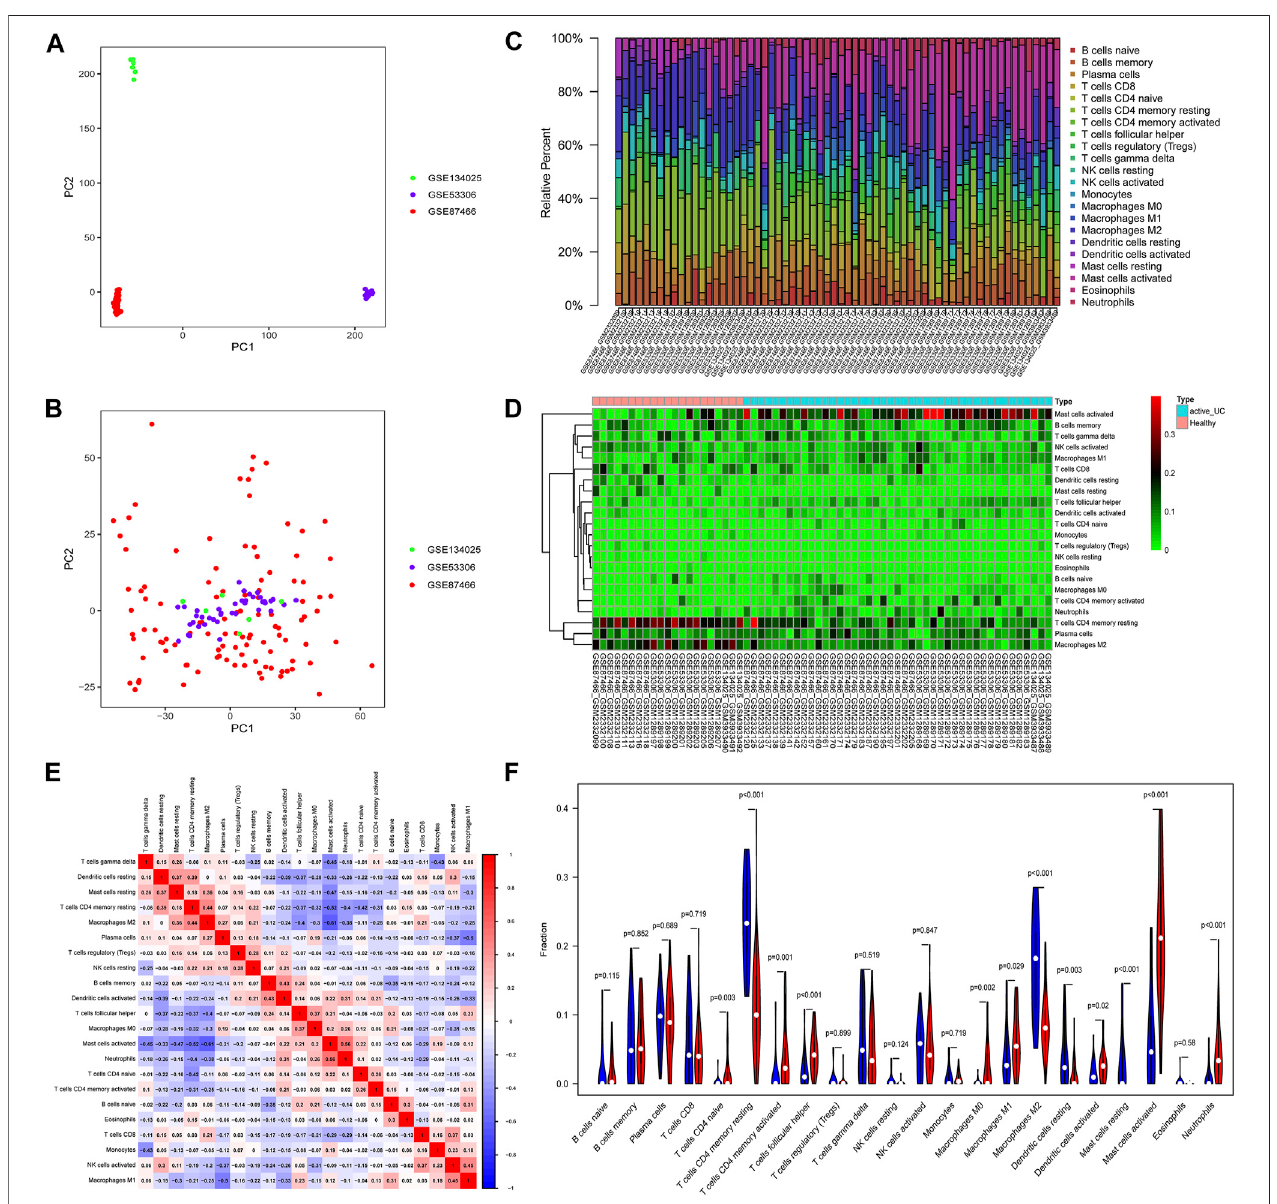
FIGURE2| Principalcomponentanalysis(PCA)andimmune-in fi ltratinglandscapeofactiveUC.ThePCAofbefore (A) andafter (B) batchcorrectionofallsamples. (C) Thedistributionof22immunecellsinallactiveUCpatientsandhealthycontrolsamplesinthetotalset. (D) Theheatmapdelineatedtheabundanceoftheimmunecell populations in each sample of active UC and healthy controls. (E) Correlation matrix of different in fi ltrating immune cells. The darker the blue, the stronger the negative correlation, and the darker the red, the stronger the positive correlation. (F) Comparison of immune cell in fi ltration in the intestinal mucosa between active UC patients and healthy control. Blue represents the healthy control group, and red represents the active UC